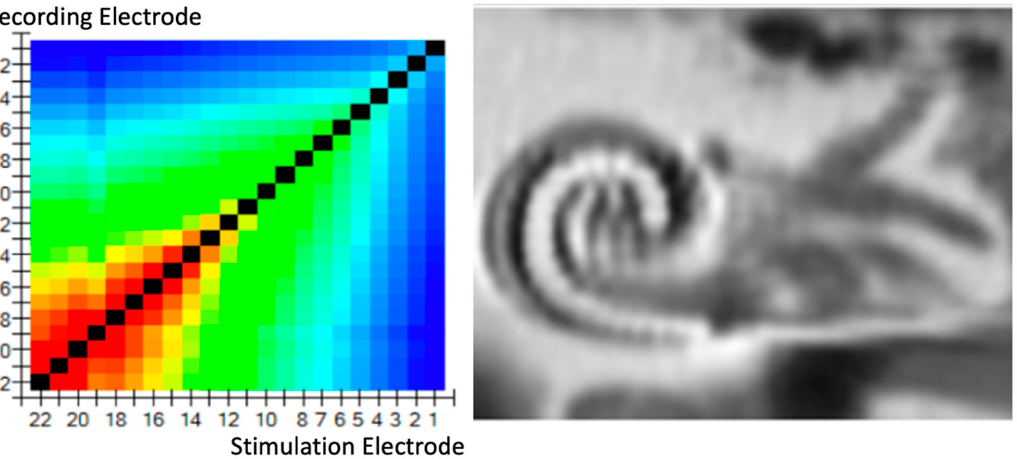
Figure 5. Correlation of TIM patterns with the radiological electrode position. CT imaging shows that higher magnitudes of the transimpedance slopes may be related to closer perimodiolar position in TB. Table 2. Temporal bones (TB), regular insertions. Electrode array position was analyzed in terms of the modiolar proximity of each electrode contact and TIM patterns.